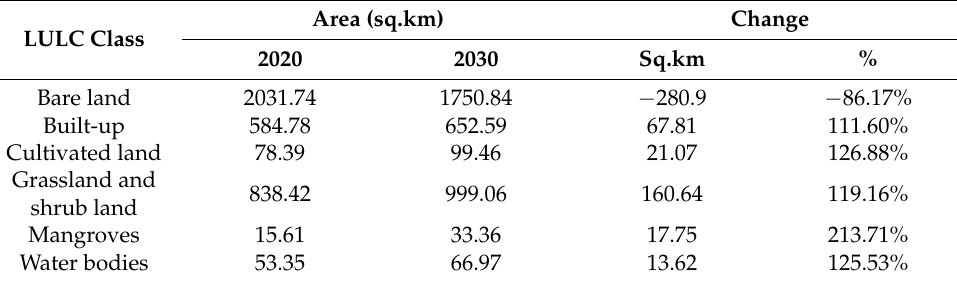
Table 10. Predicted LULC changes for Karachi city in